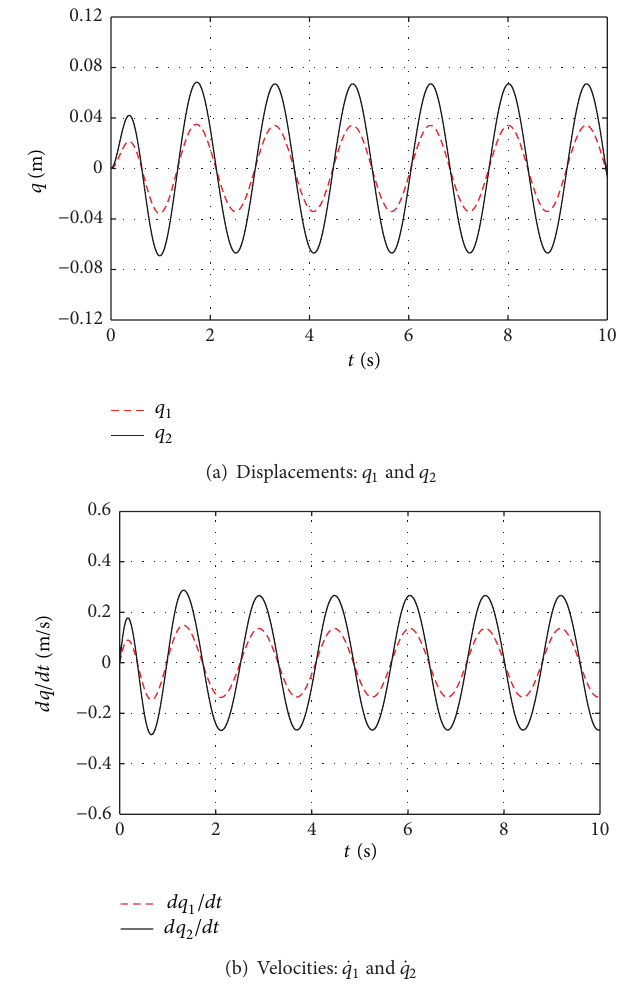
Figure 1: System